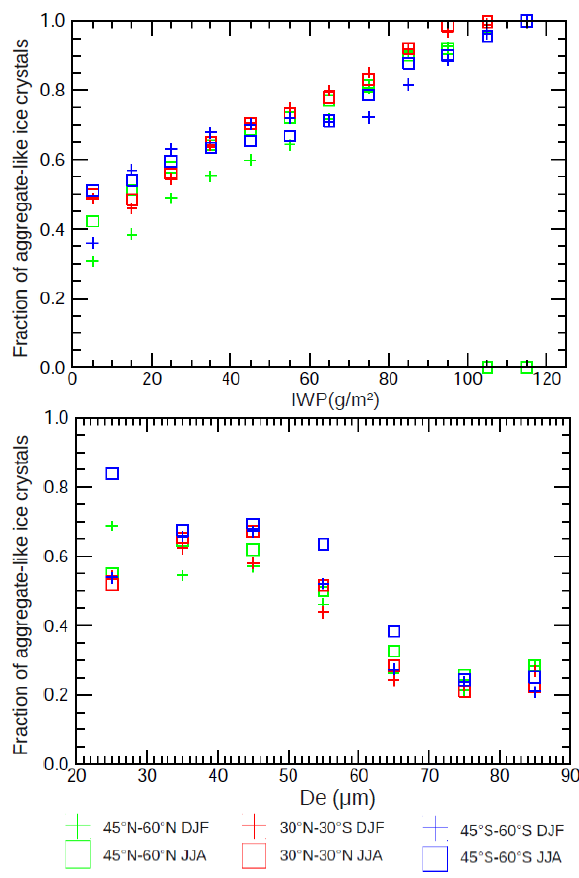
Fig. 10. Relationships between fraction of aggregated-like ice crystals and IWP (top) and between fraction of aggregated-like ice crystals and D e (bottom) over ocean, separately for boreal winter (+ signs) and for boreal summer (squares). Green symbols are for NH midlatitudes, red for the tropics and blue for SH midlatitudes. Statistics is averaged over the period 2003-2009.